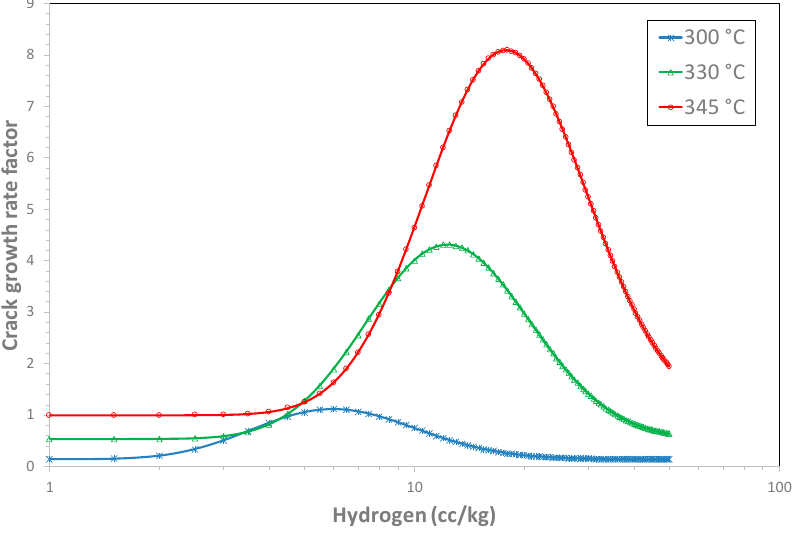
Figure 14. Calculated effect of hydrogen on the crack growth rate factor of Nickel-Base Alloys for the temperatures 300 °C, 330 °C and 345 °C.